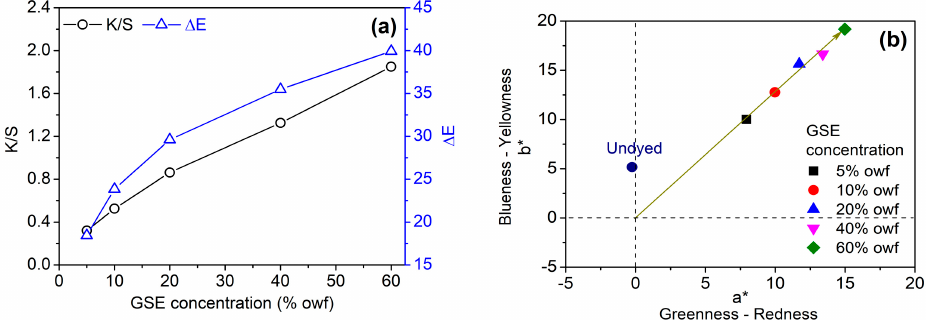
Figure 5. Color depth (K/S at 450 nm) and color difference ( a ), and chromaticity coordinates ( b ) of cotton fabrics dyed with GSE at various concentrations.